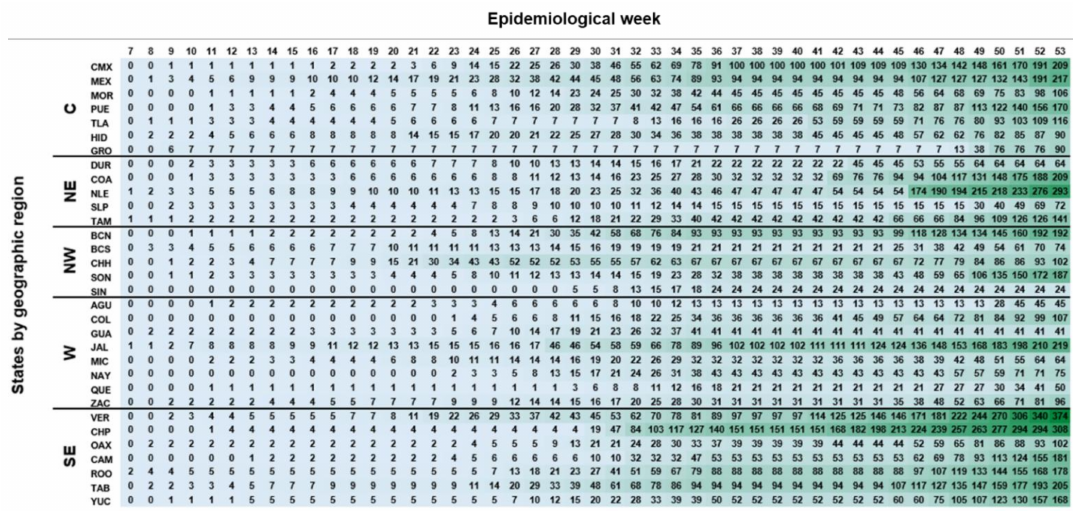
Figure 3. Heat map of accumulated cases by epidemiological week of each state of the Republic. Center region (C): Mexico City (CMX), State of Mexico (MEX), Morelos (MOR), Puebla (PUE), Tlaxcala (TLA), Hidalgo (HID), Guerrero (GRO); Northeast (NE): Durango (DUR), Coahuila (COA), Nuevo Le ó n (NLE), San Luis Potos í (SLP), Tamaulipas (TAM); Northwest (NW): Baja California (BCN), Baja California Sur (BCS), Chihuahua (CHH), Sonora (SON), Sinaloa (SIN); West (W): Aguascalientes (AGU), Colima (COL), Guanajuato (GUA), Jalisco (JAL), Michoac á n (MIC), Nayarit (NAY), Quer é taro (QUE), Zacatecas (ZAC); Southeast (SE): Veracruz (VER), Chiapas (CHP), Oaxaca (OAX), Campeche (CAM), Quintana Roo (ROO), Tabasco (TAB), and Yucatan (YUC). Six of the states (SIN, GRO, NAY, COL, OAX, and QUE) did not comply with the shipment of samples mentioned in Table S1.